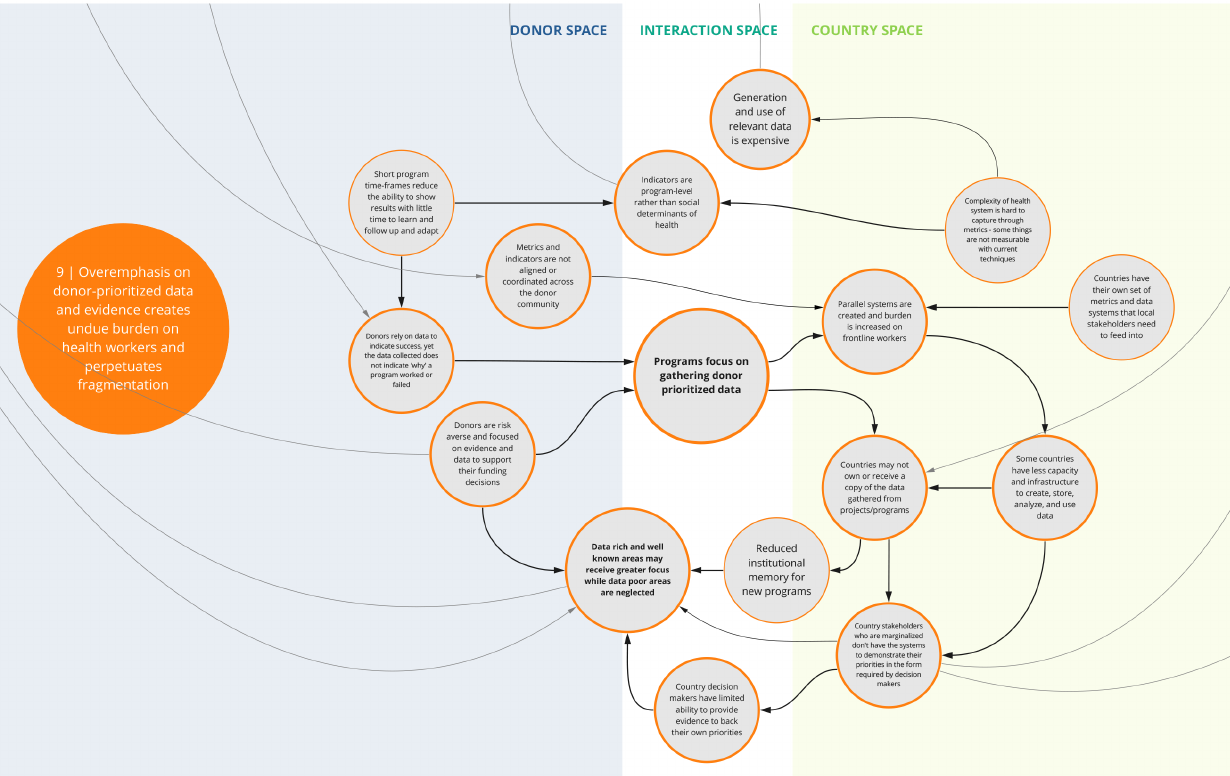
Figure 10. Syndrome 9: Overemphasis on donor-prioritized data and evidence creates undue burden on health workers and perpetuates fragmented data